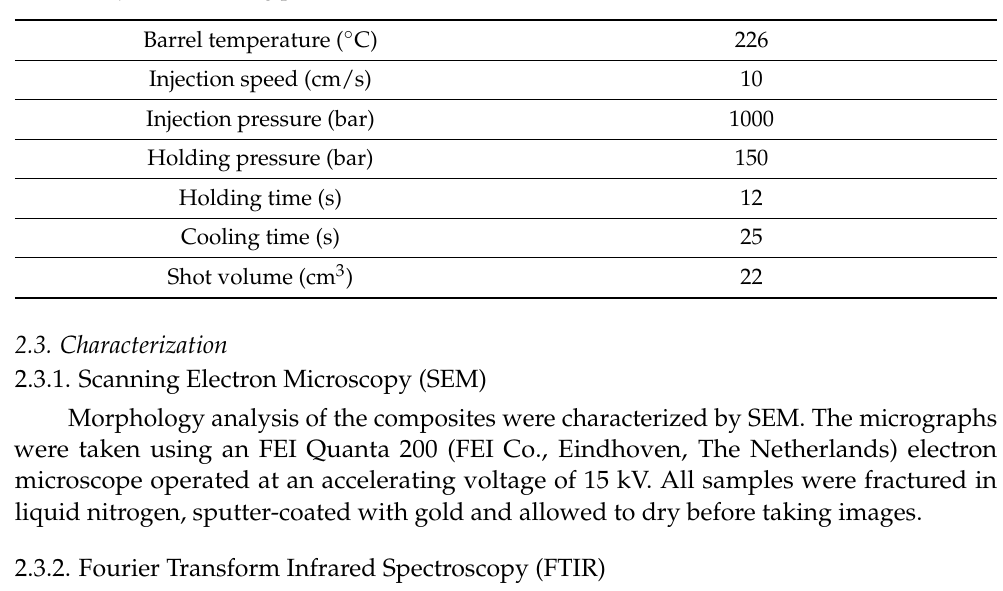
Table 1. Injection molding